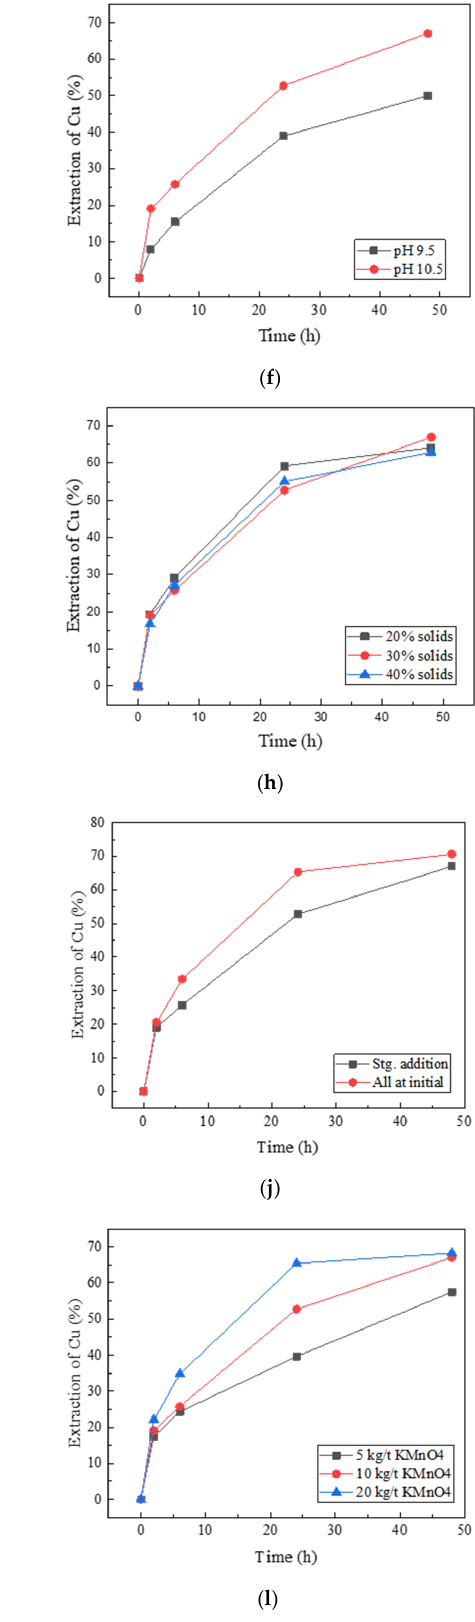
Figure 5. Effect of ( a , b ) glycine concentration, ( c , d ) pH modifier, ( e , f ) pH, ( g , h ) solid content, ( i , j ) method of permanganate addition and ( k , l ) permanganate addition on the extraction of gold and copper. Table 3. Ammonia additions at different glycine concentrations (10 kg/t KMnO 4 (stg. addit.), with a pH level of 10.5, with 30% solids and at 30 °C).